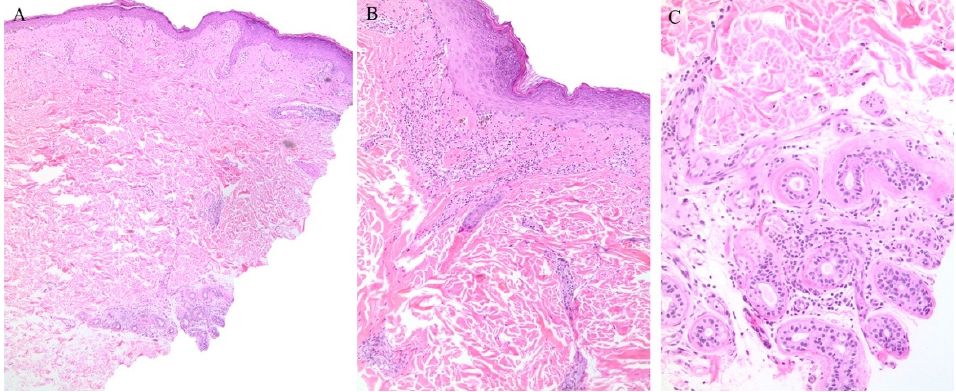
Figure 2. ( A – C ) Graft versus host disease with perieccrine inflammation.